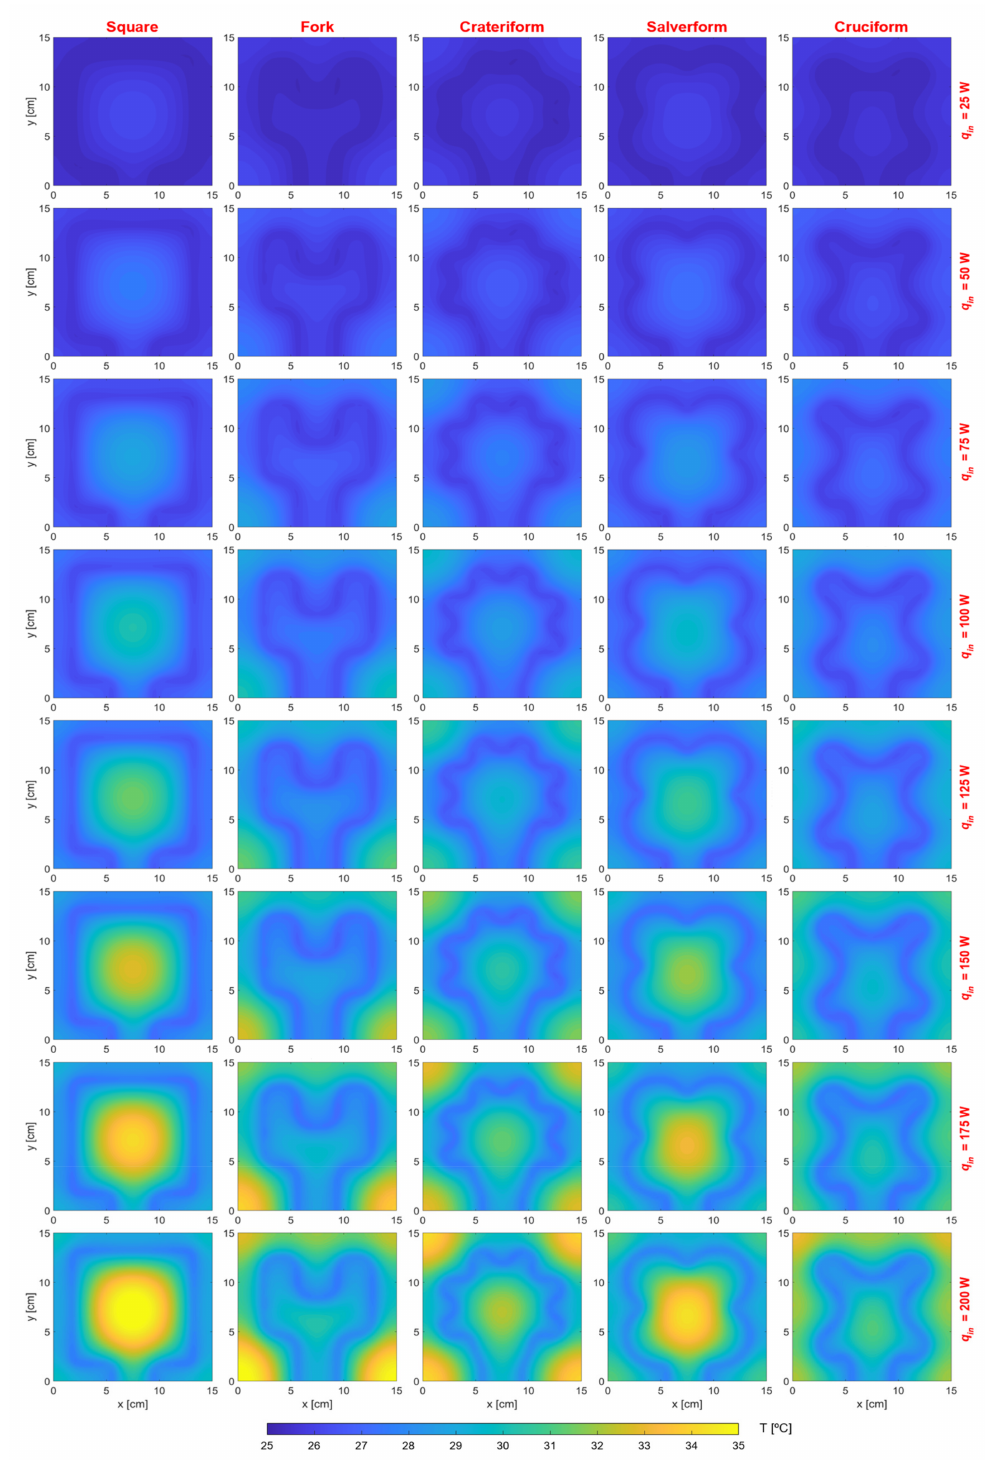
Figure 8. Evolution of the temperature distribution across the plate with the thermal power input under steady state